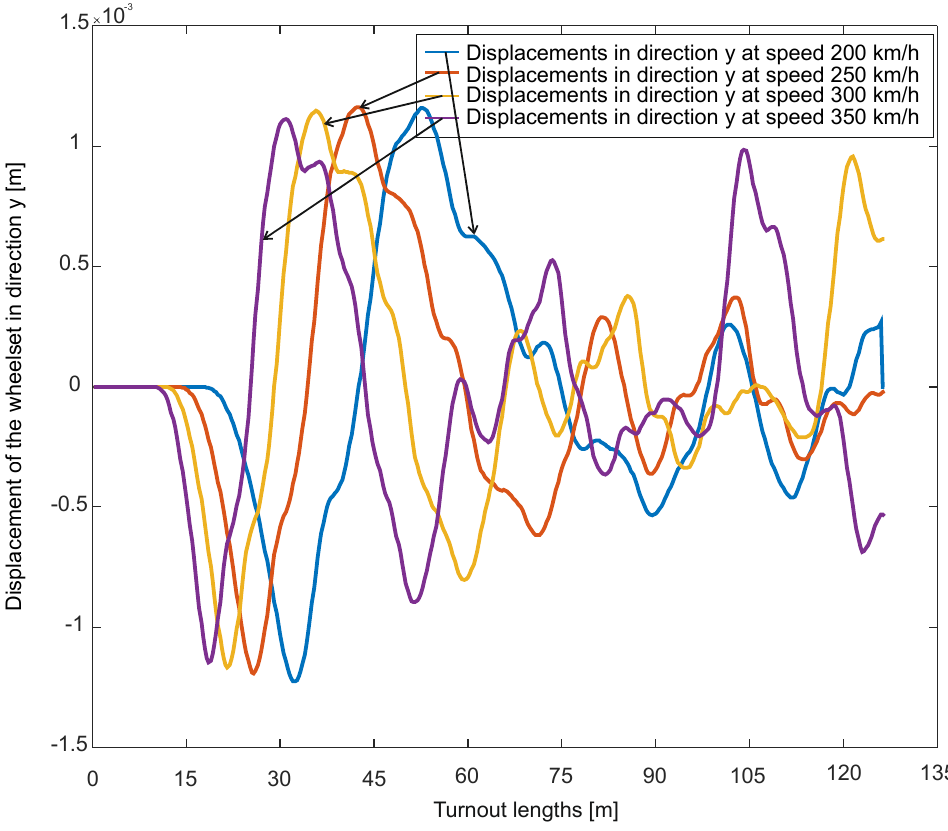
Figure 17. Displacement of the wheelset in y direction at various speeds.